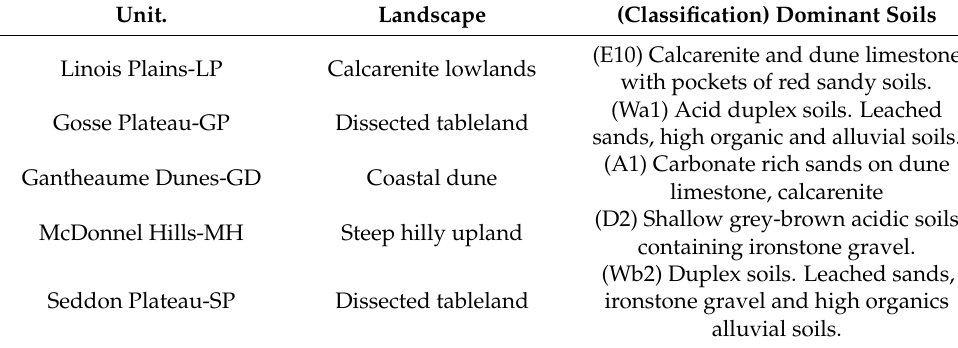
Table 1. Landscape units associated with soils in fire affected regions of Figure 2. Dominant soils reflect classification used by Northcote [83].